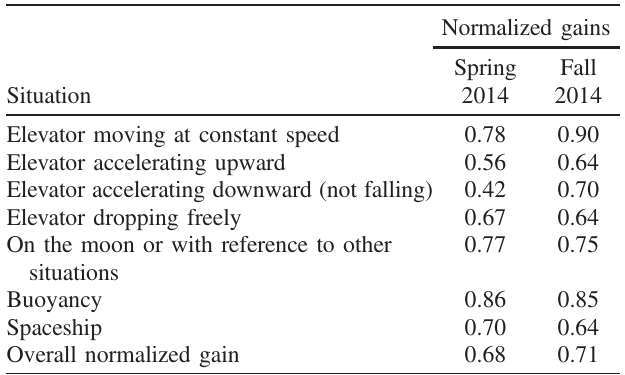
TABLE IV. Normalized gains for each situation considered.